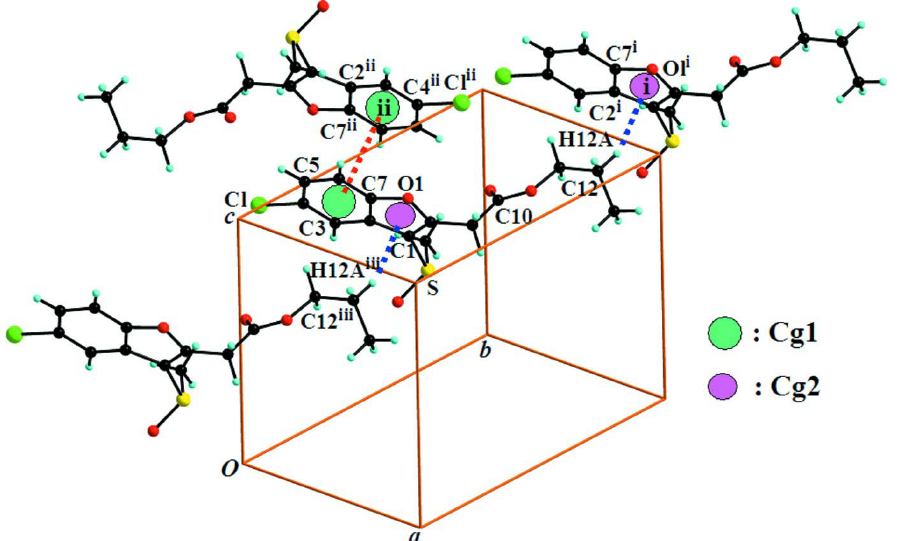
Figure 2 π — π and C—H··· π interactions (dotted lines) in the title compound. Cg denotes the ring centroid. [Symmetry code: (i) x, y+1, z; (ii) -x, -y+1, -z+2; (iii) x, y-1,